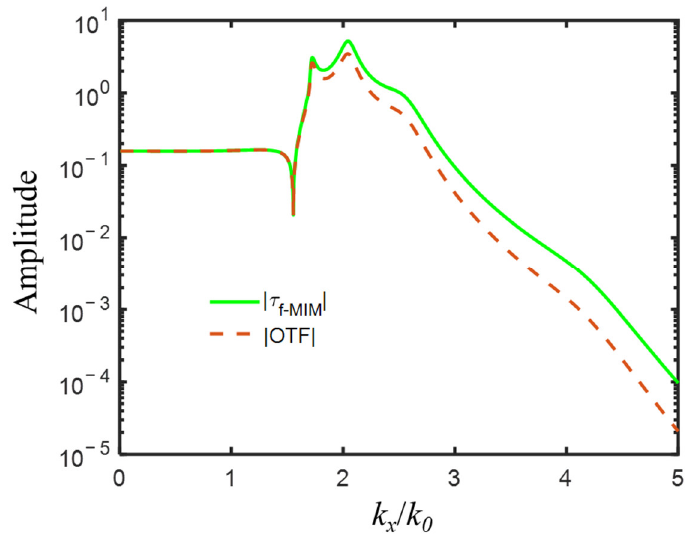
(cid:12) (cid:12) (cid:12) (cid:12) with (cid:12) (cid:12) τ f − MIM f MIM